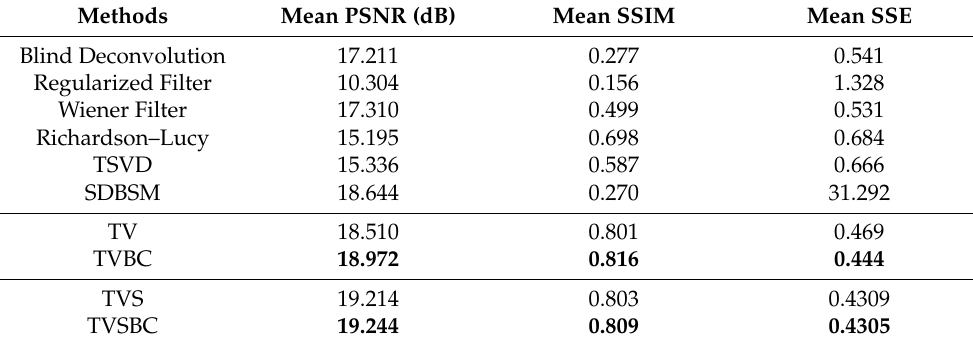
Table 2. Mean PSNR (dB), SSIM and SSE results with 500